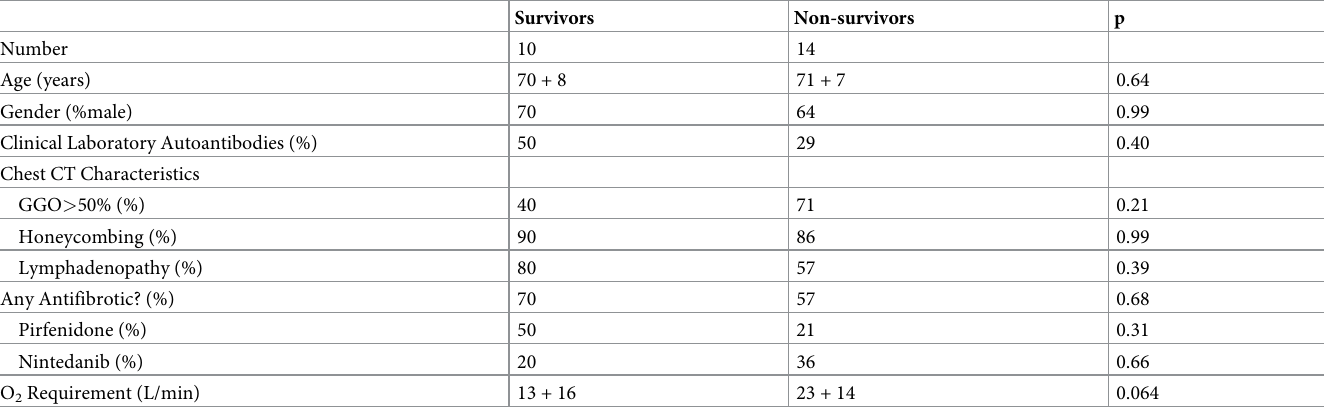
Table 2. Patient demographic characteristics.